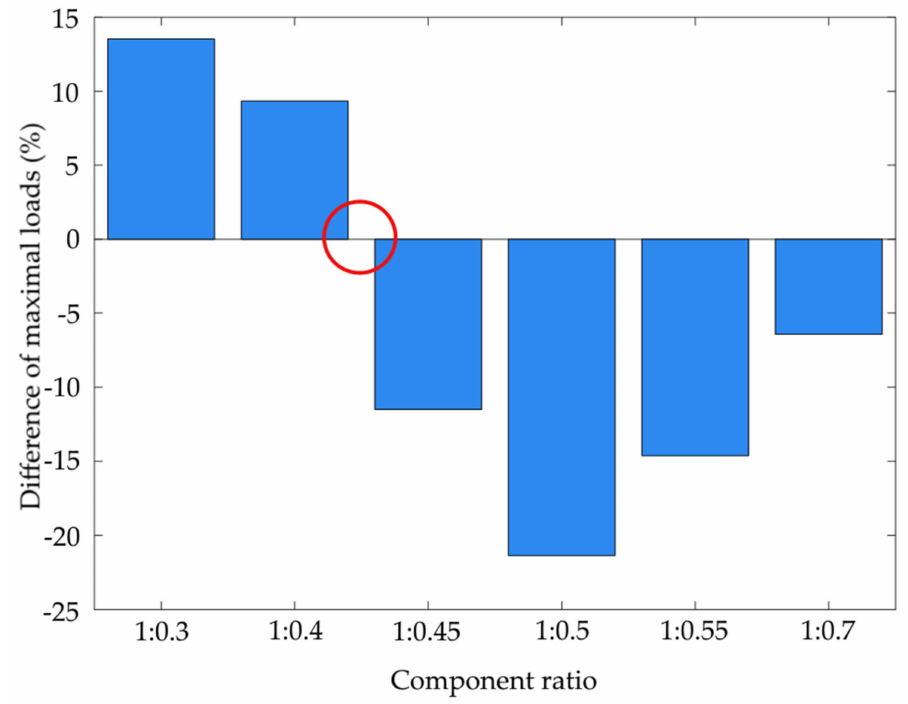
Figure 5. Relative change of the average static strength between the heat-held cured joints and the ambient temperature-cured